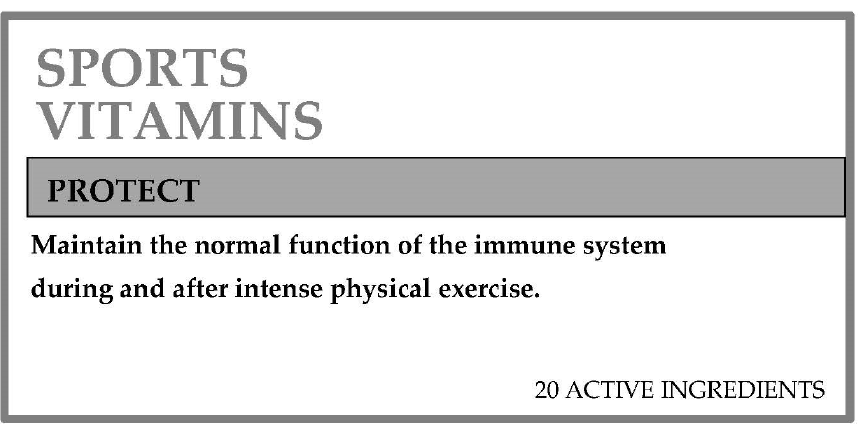
Figure 5. An example of the front of a dietary supplement label. Adapted from a commercial product .